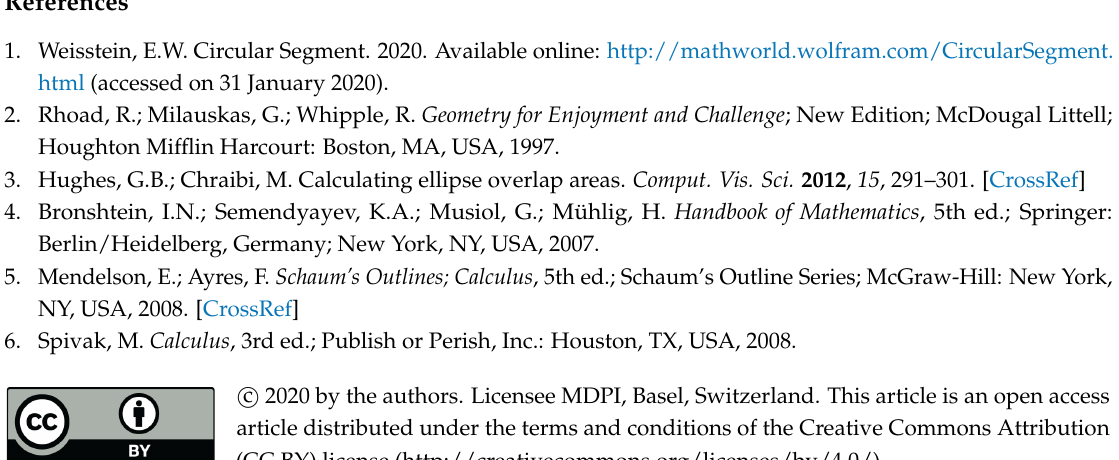
Figure 5. Visualization of the lower and upper Darboux sum of the function y = [ 0,1 ] for n = 10 and lower Darboux sum for n =